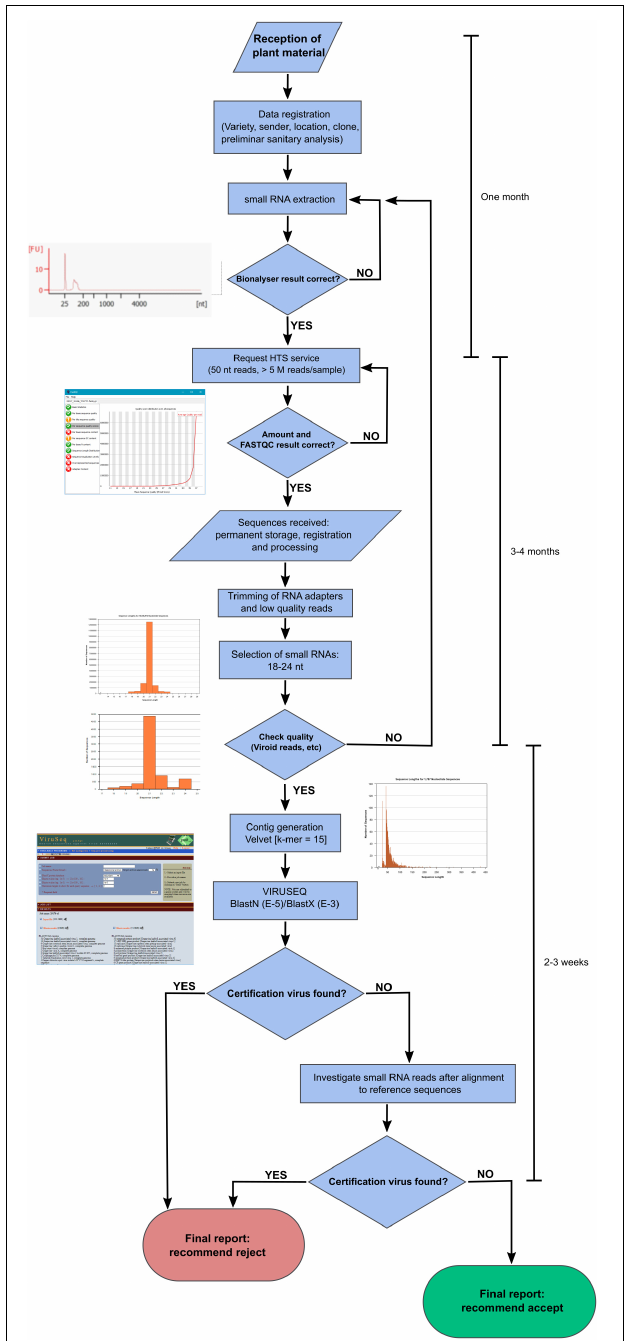
FIGURE 5 | Flux diagram of an HTS pipeline for virus certification in grapevine.